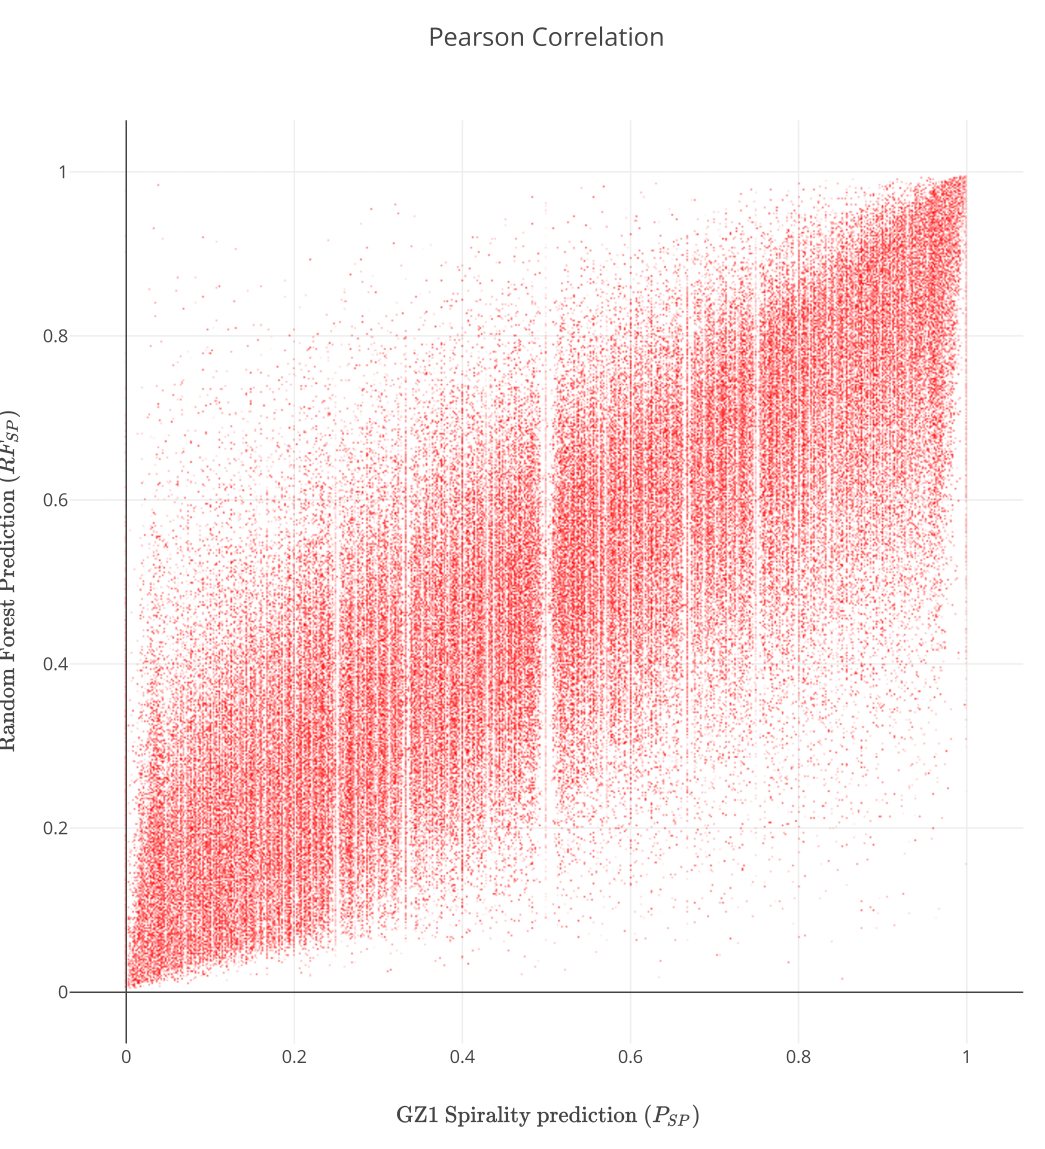
Figure 5. Scatter plot of both training data and test data depicted in Table 5: our predicted spirality (vertical) vs. the fraction of GZ1 humans voting for spiral (horizontal). The points cluster around the line y = x , depicting good agreement. Additionally, more than 98% of the galaxies have | x − y | ≤ 0.3 and approximately 95% of the objects fall under | x − y | ≤ 0.2. The vertical white lines appear because the fraction of human voters is a ratio of discrete